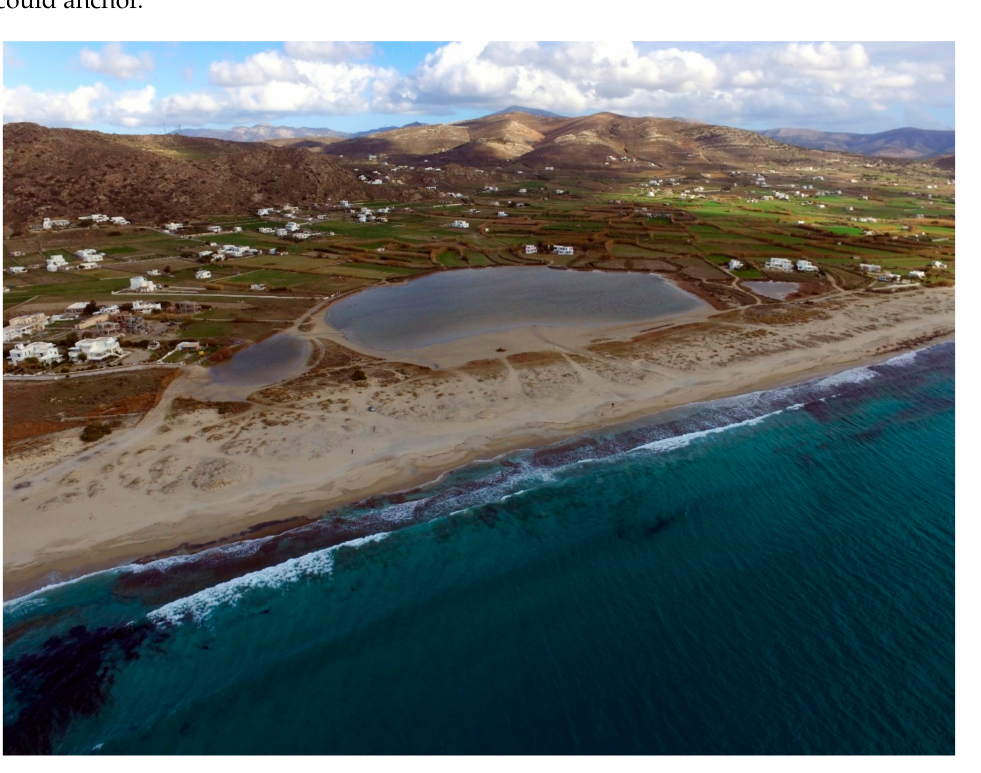
Figure 6. The coastal zone of Vigla